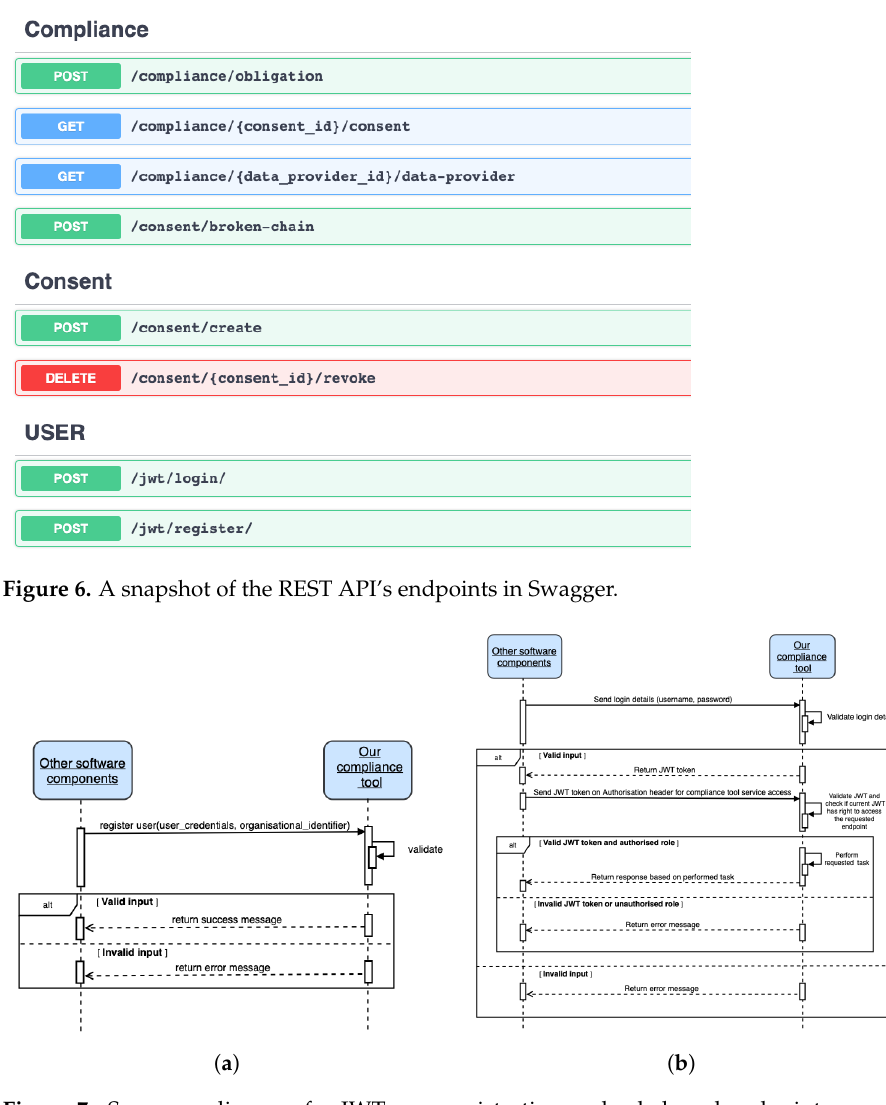
Figure 7. Sequence diagram for JWT user registration and role-based endpoint access by other software components. Any third-party application that interacts with our tool is represented by the other software components. ( a ) Sequence diagram JWT user registration. ( b ) Sequence diagram for role-based service